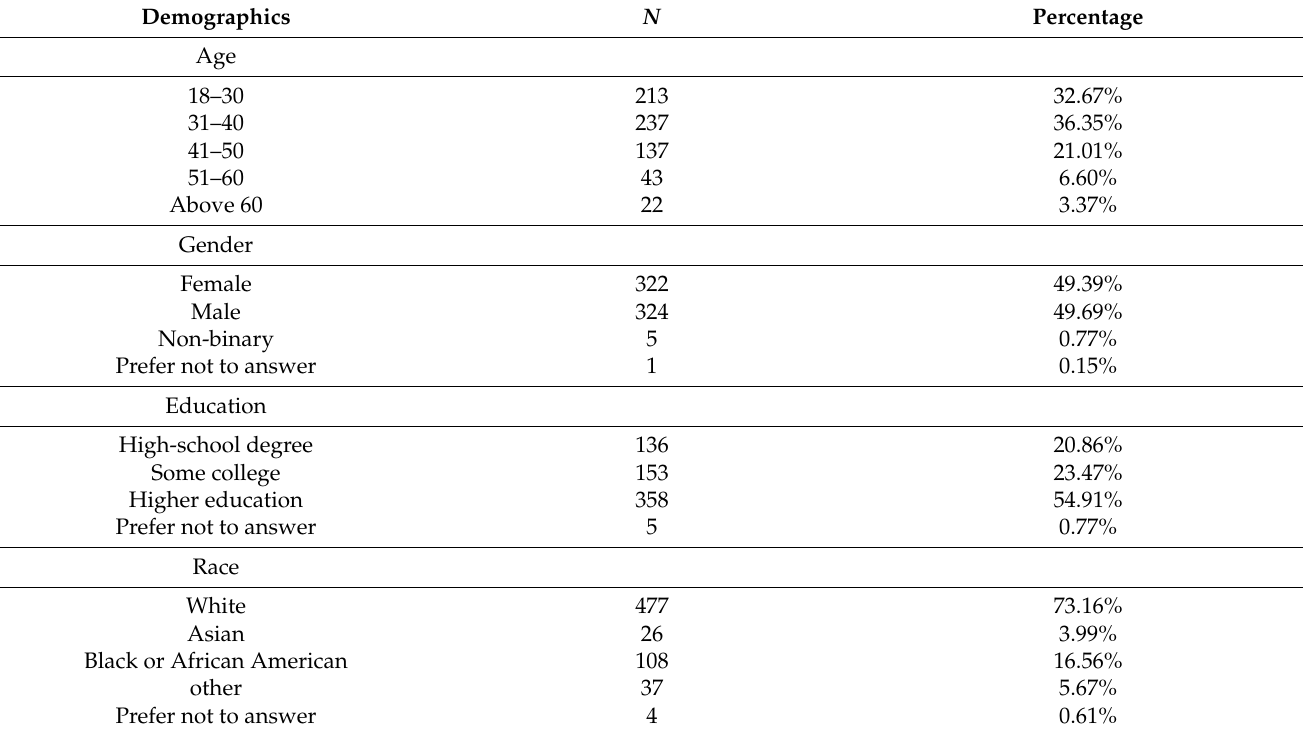
Table 1. Participant demographic